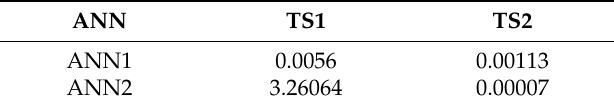
Table 2. Classical ANOVA F-test results obtained for d y* values.